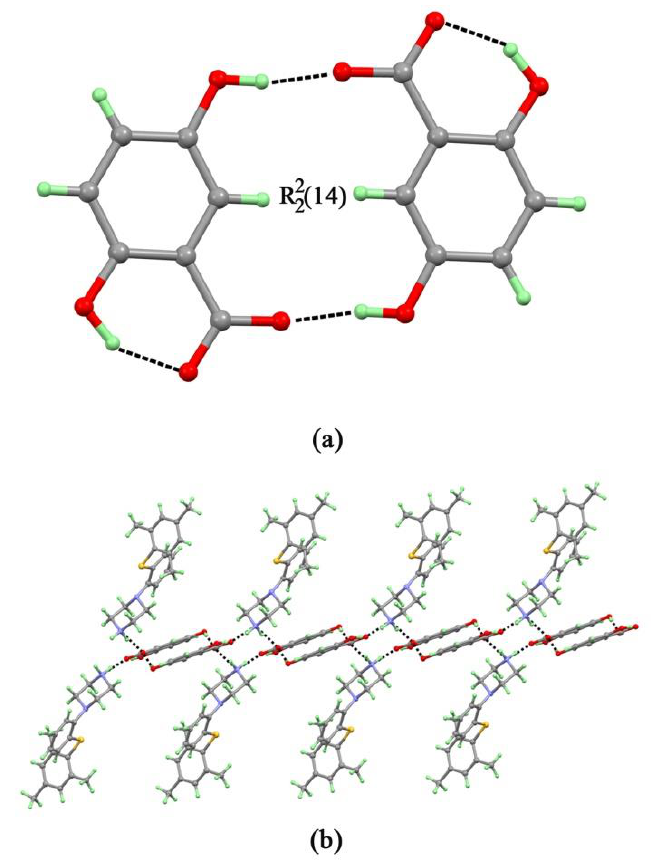
Figure 3. ( a ) Two 25BA anions formed an R 2 (14) synthon through O4 − H4 ··· O2 hydrogen bonds. ( b ) The sandwich 3D structure of the VOT-25BA salt.